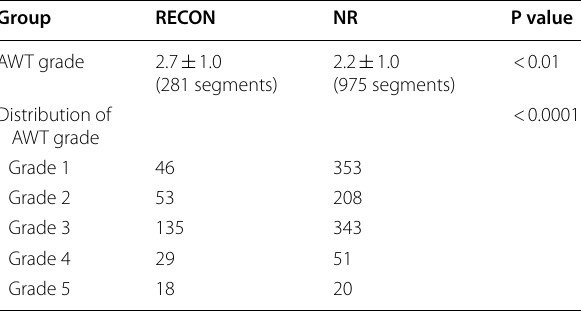
Table 3 Atrial wall thickness grade of reconnected vs. non‑ reconnected PV